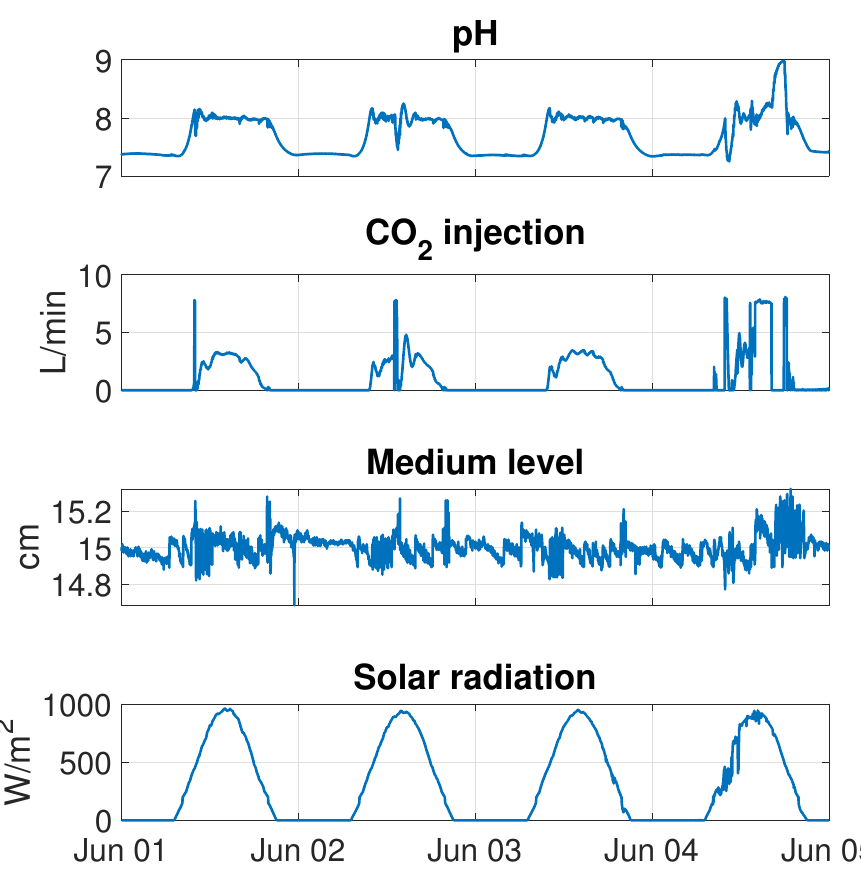
Figure 3. Sample data from four consecutive days from the freshwater